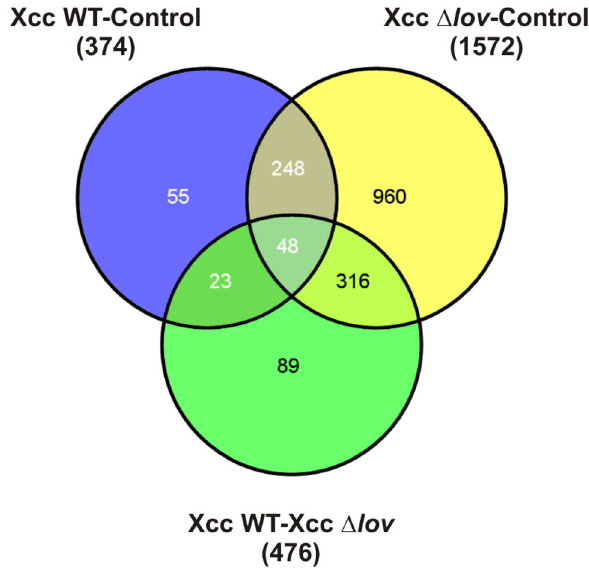
Figure 1. Transcriptomic analysis in orange leaves inoculated with Xanthomonas citri subsp. citri. Citrus cDNA microarray hybridization was performed 24 h after inoculation of orange leaves with WT and Δ lov strains of X. citri subsp. citri and control treatment (10 mM MgCl independents biological samples were used. Venn diagrams show the classification of differentially expressed microarray probes according to the following comparisons: X. citri